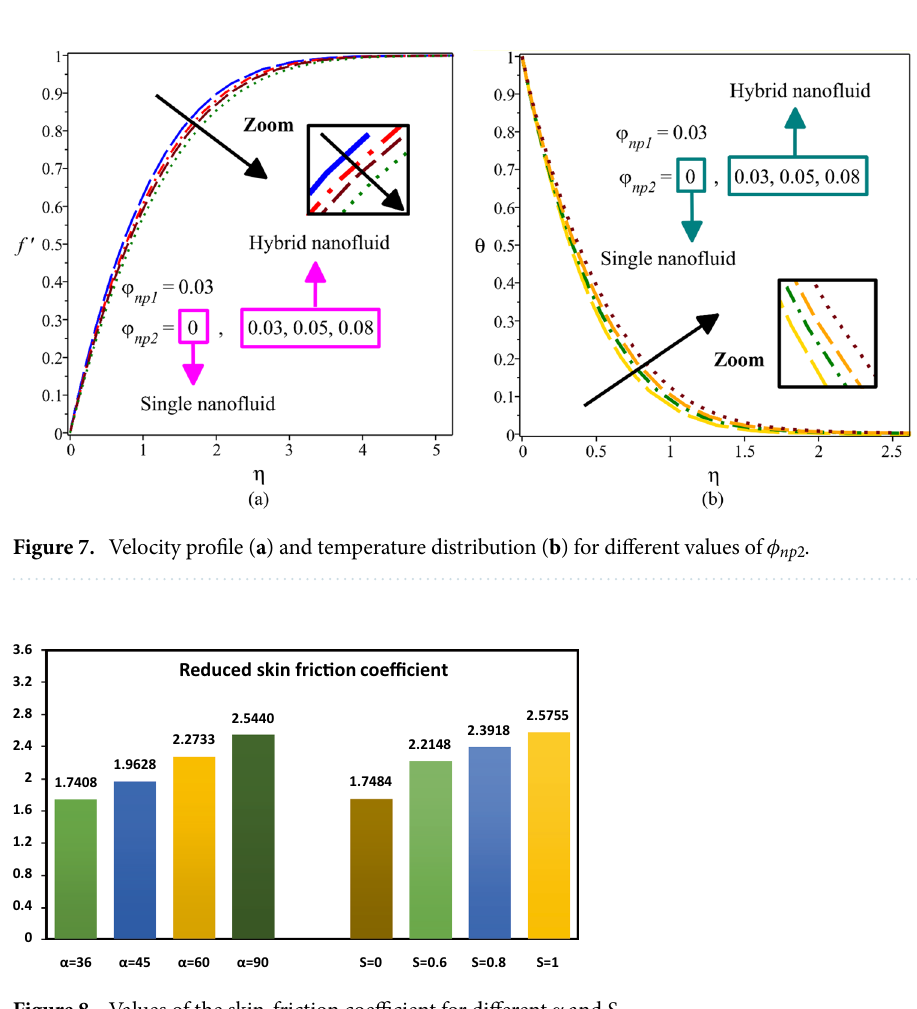
Figure 8. Values of the skin-friction coefficient for different α and S